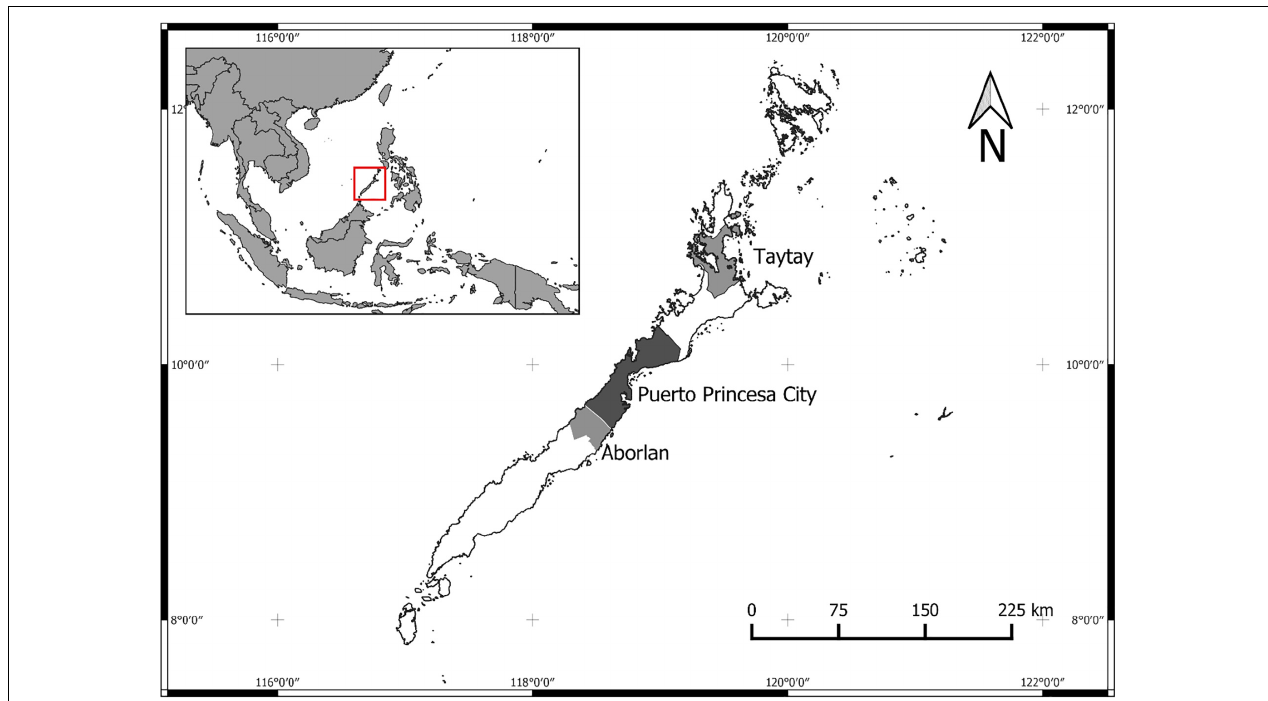
FIGURE 1 | Map of Palawan showing an inset of the Philippines, with Palawan highlighted with a red box. Aborlan, Puerto Princesa City, and Taytay, the study sites where the coastal communities were located, are highlighted in light and dark